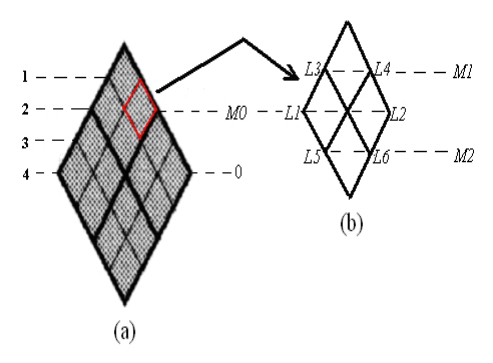
Figure 3. The structure of the diamond grid